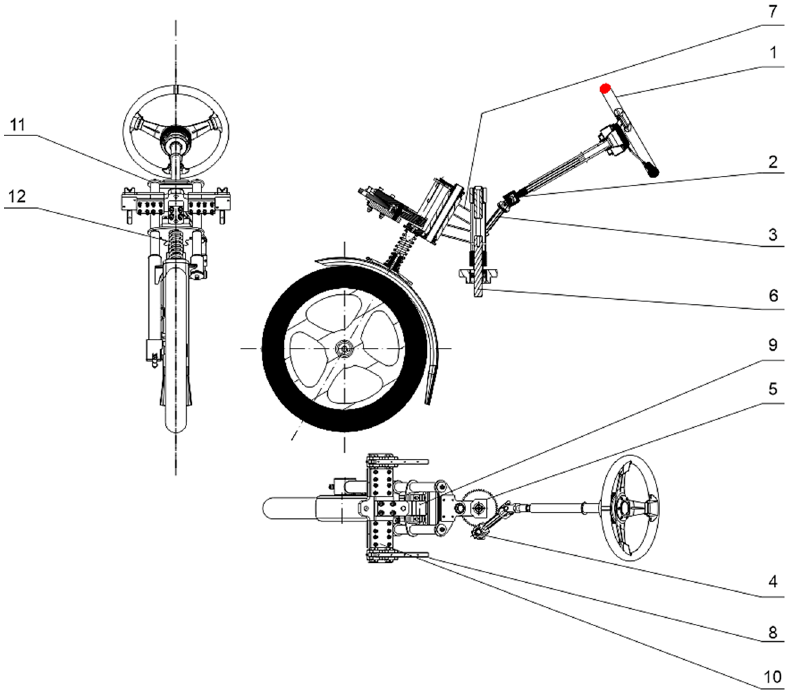
Figure 25. Draft, side view and footprint of mounting the front steered wheel for the three-wheeled vehicle.